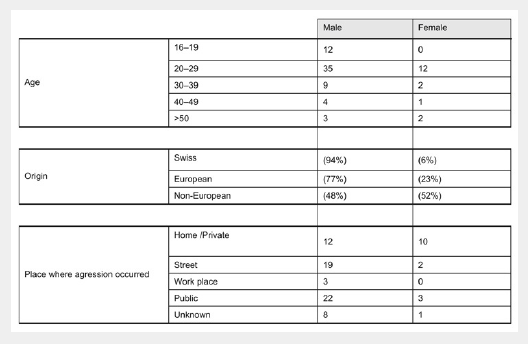
Distribution of ages, origin of patients and places where aggression occurred according to gender, in our cohort of 80 consecutive cases of stab injuries.